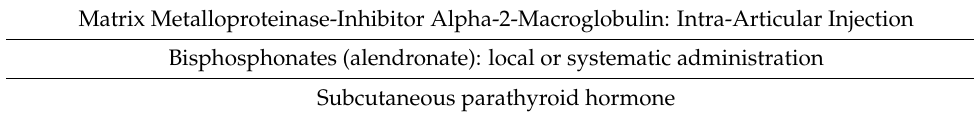
Table 4. Drugs employed in anterior cruciate ligament reconstruction.